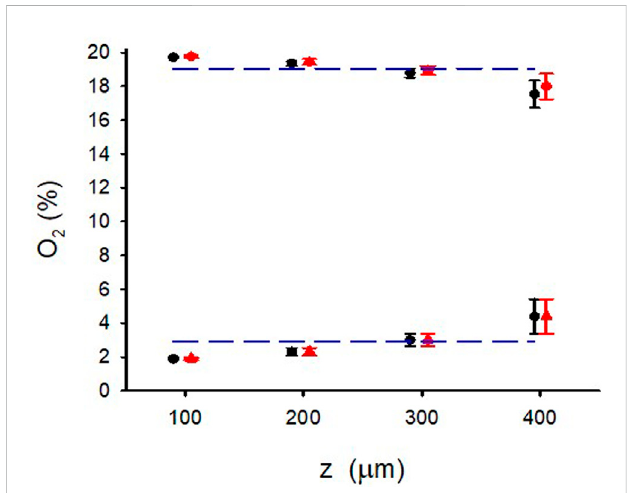
FIGURE 6 Maximum and minimum of O 2 for different positions ( z ) in the W = 500 μ m lung extracellular matrix hydrogel when the intermittent air circulatingbeneaththemembranewas20%O 2 for30 s0%O 2 for30 sin an acellular hydrogel and when the hydrogel was seeded with two different concentrations of